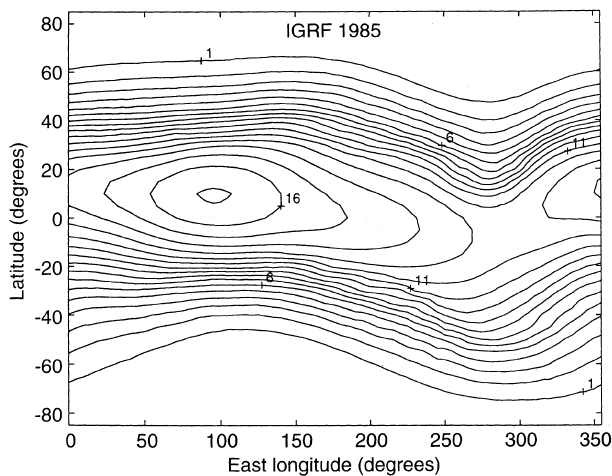
Fig. 2. Isorigidity contours of vertical cosmic ray e(cid:128)ective cuto(cid:128) rigidities (in GV), at an altitude of 100 km, computed by tracing trajectories in the geomagnetic field represented by the IGRF model for epoch 1985 with maximum n (cid:136) 10